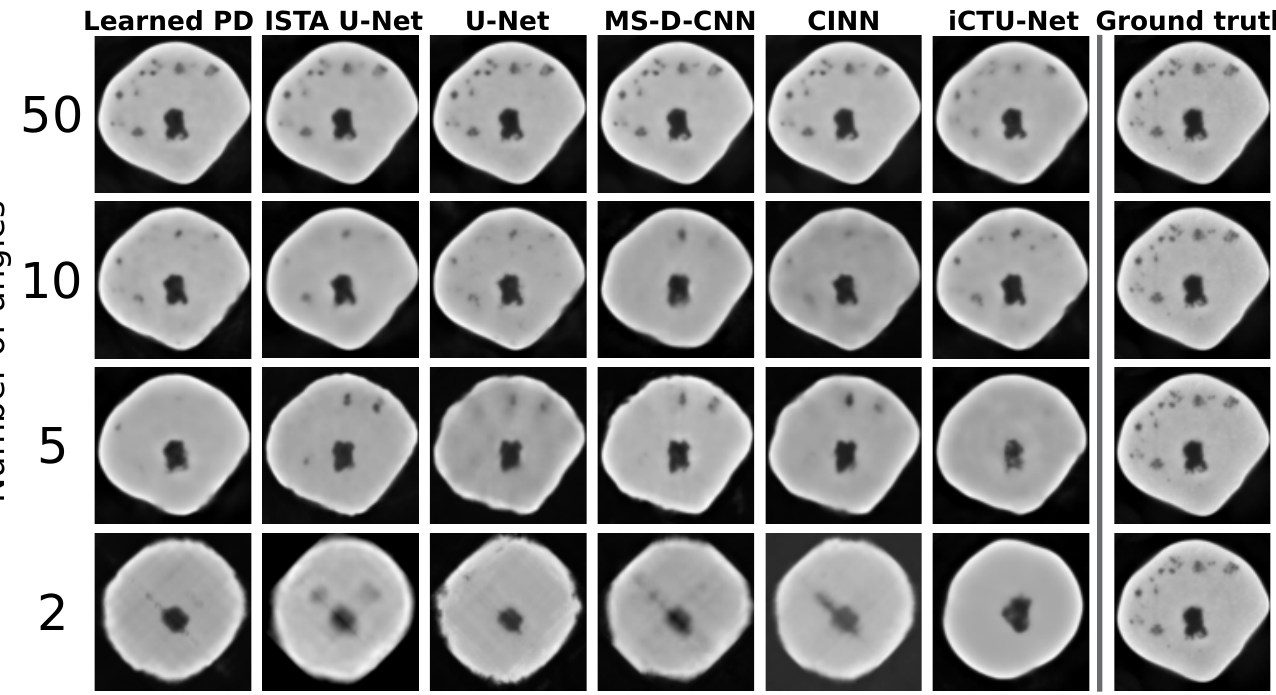
Figure 6. Visual overview of one apple slice with bitter pit for different learned methods. Evaluated on Gaussian noise. The quality of the reconstruction deteriorates very quickly for a reduced number of angles. For the 2-angle case, none of the methods can reconstruct the exact shape of the